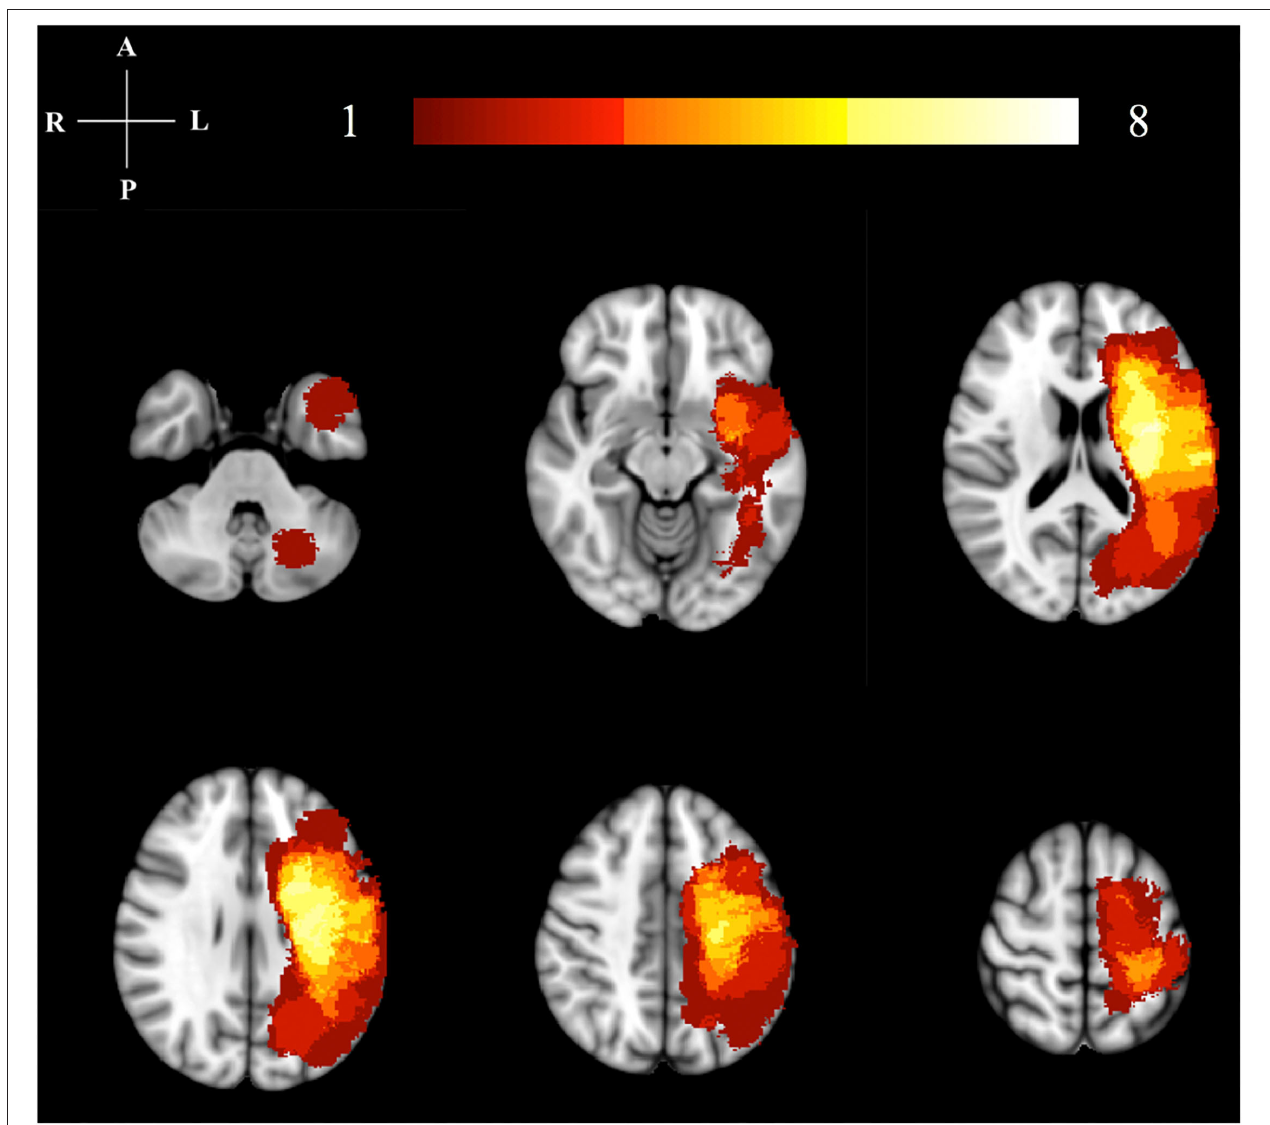
FIGURE 1 | Lesion location map. This image illustrates the lesion distribution for our study. The color bar and numbers represent the number of subjects with a lesion in that area. The highest lesion distribution in shown in bright colors (yellow/white). All right hemisphere lesions have been flipped to the left hemisphere for